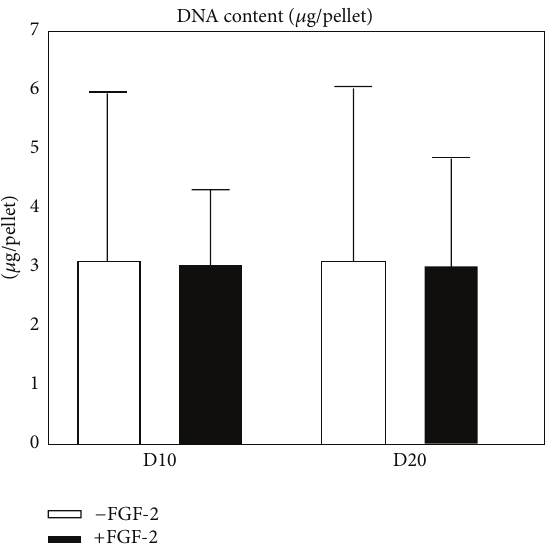
Figure 3: DNA content ( 𝜇 g/pellet) on days 10 and 20 of chondro- genic culture, with (white) or without (black) FGF-2 supplementa- tion ( 𝑛 = 6